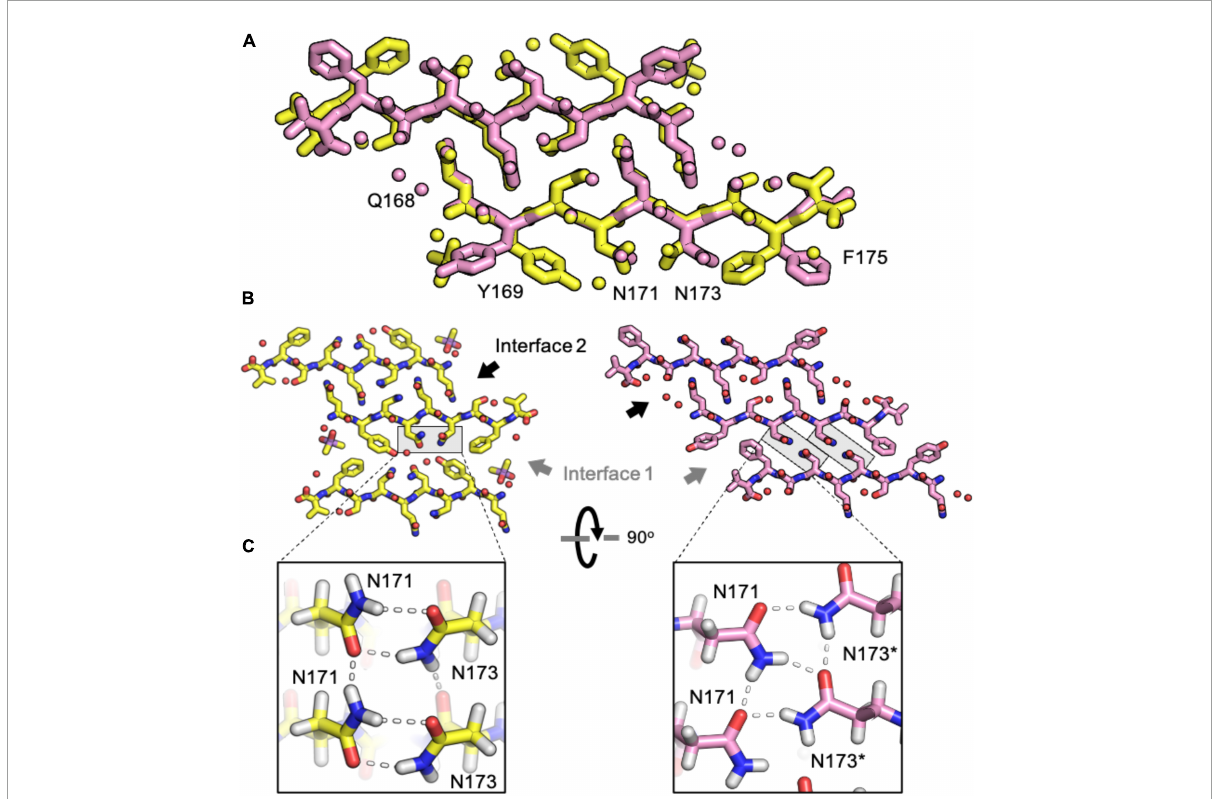
FIGURE5 Comparison of naked mole rat and rabbit loop structures. (A) Naked mole rat (yellow) and rabbit (pink) loop structures share a common interface seen in packing category 2. (B) Interface 1 is composed of inward facing aromatic residues and a polar clasp between N171 and N173 on the same strand for all structures regardless of packing category with the exception of the rabbit loop structure (right). (C) A polar clasp is formed in both non-rabbit (left) and rabbit (right) structures, however, in the rabbit structure the clasp is formed by N171 and N173 on mated sheets rather than via interactions within a single